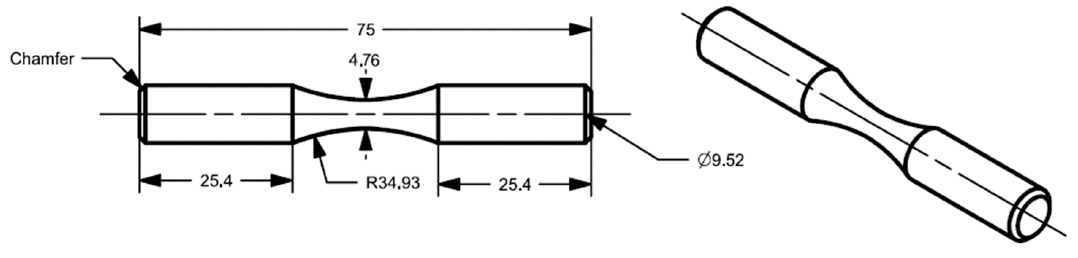
Figure 2. Fatigue sample dimensions used in testing (in